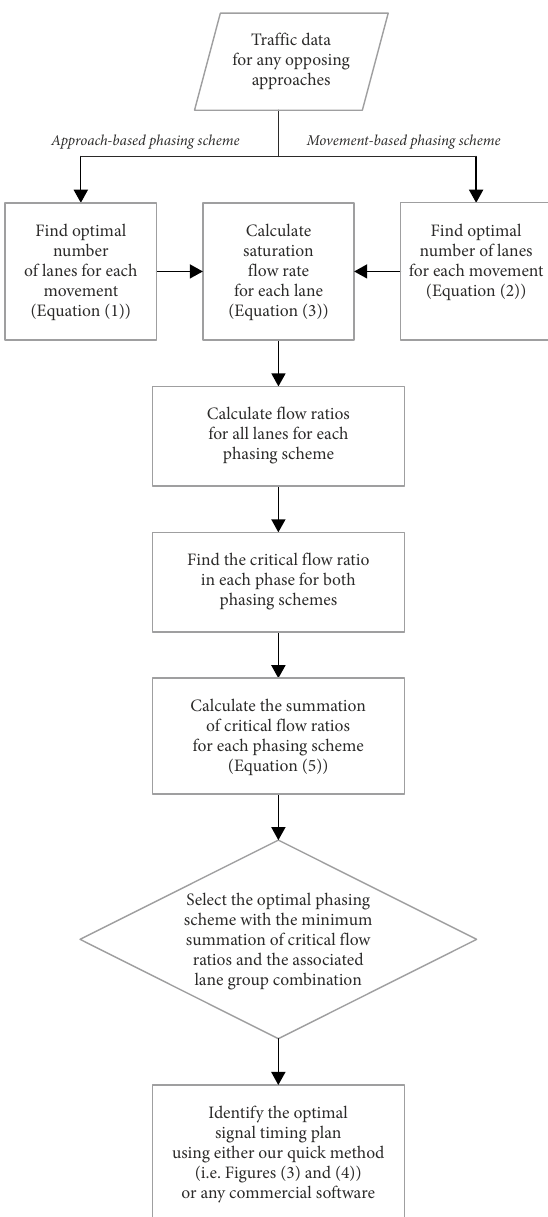
Figure 5. Flowchart of the proposed